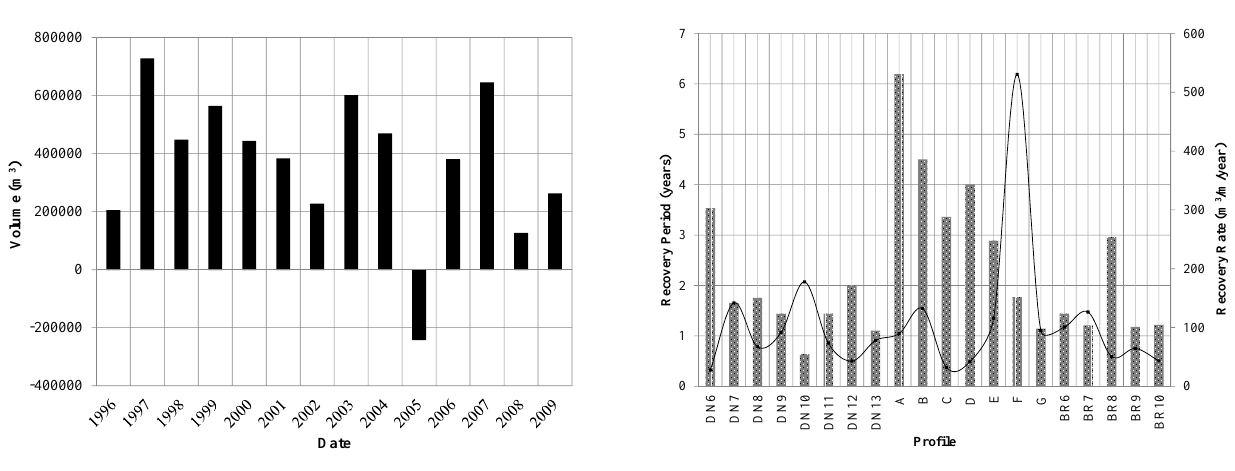
Fig. 6. Annual sediment losses for the Durban Bight (A – 23) accounting the sediment volumes contributed by the sand bypass scheme.